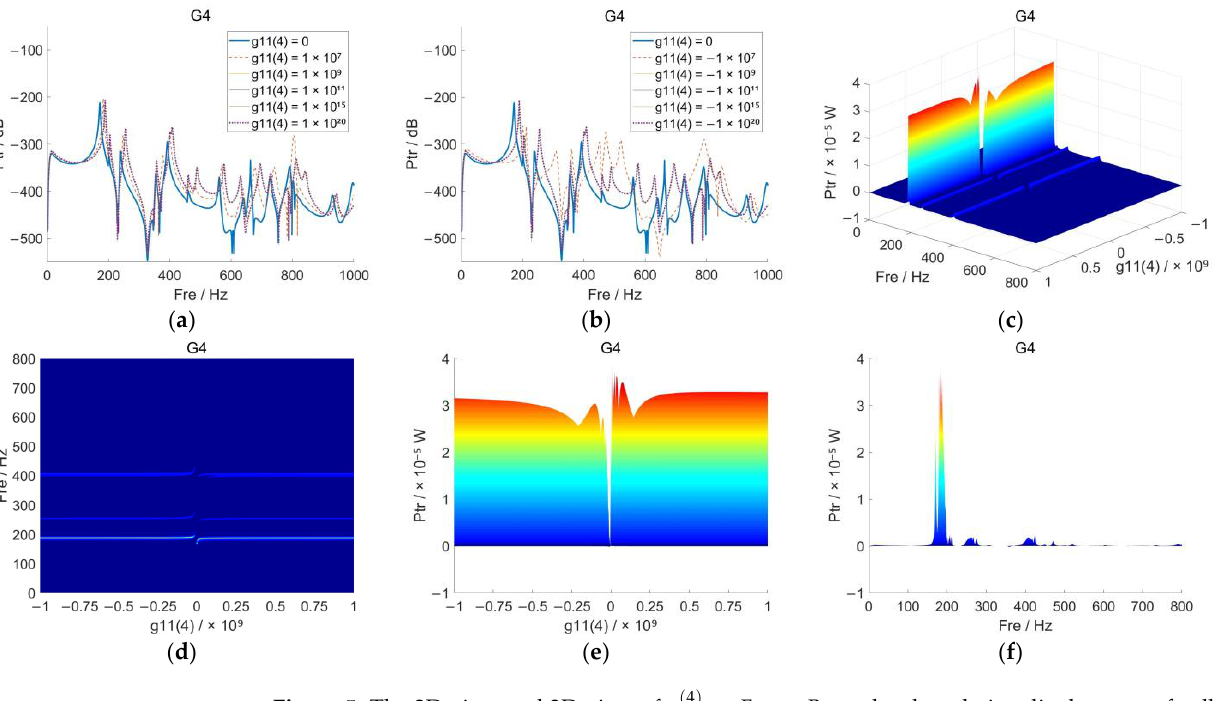
P curves under tr